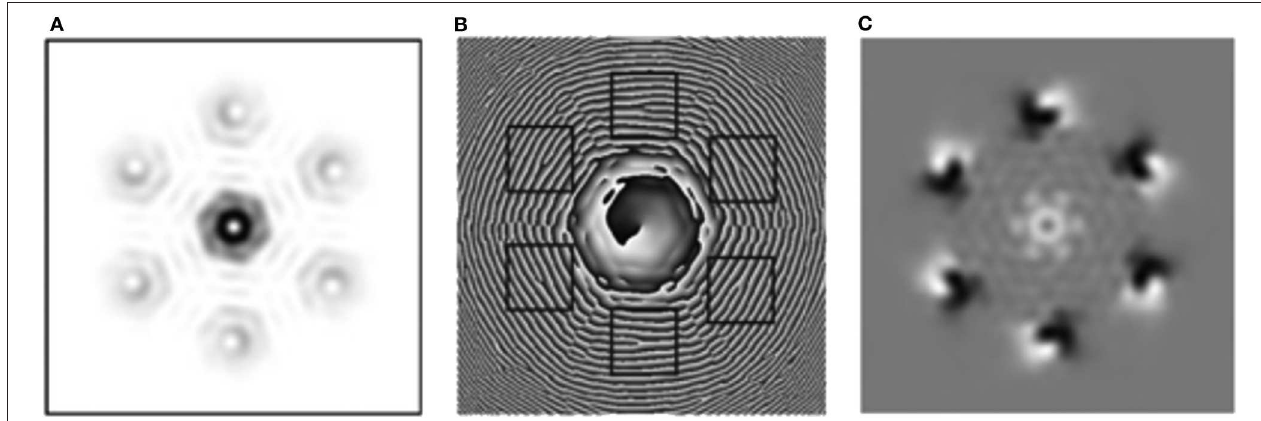
FIGURE 4 | Intensity (A) , phase (B) , and OAM density (Equation 11) (C) distributions of the synthesized vortex beam at the end of the distance z / z d 0 simulation domain of L / a 0 80, 3096 3096 computational grid. Squares show the zones containing peripheral screw phase dislocations at the vertices of the = × regular hexagon [ 18].